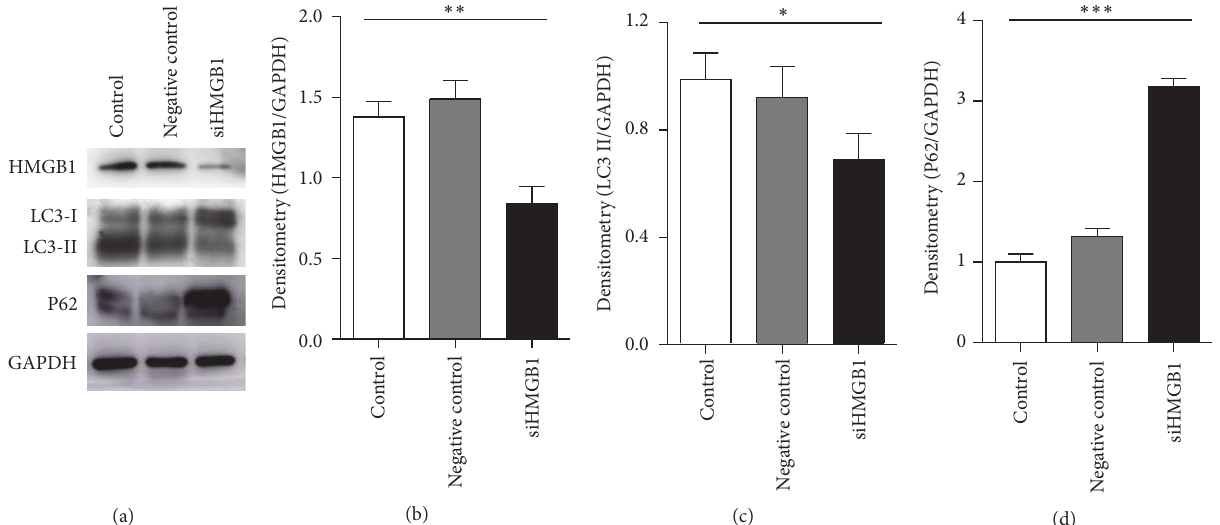
Figure 3: Autophagy was weakened by siRNA knockdown of HMGB1. HMGB1 siRNA or control siRNA was transfected into 3T3-L1 preadipocytes by lipo2000. (a) The expression levels of HMGB1, LC3, and P62 were examined by Western blot. (b–d) Quantification of protein levels normalized by GAPDH. ∗ 𝑃 < 0.05 , ∗∗ 𝑃 < 0.01 , and ∗∗∗ 𝑃 < 0.001 , versus the